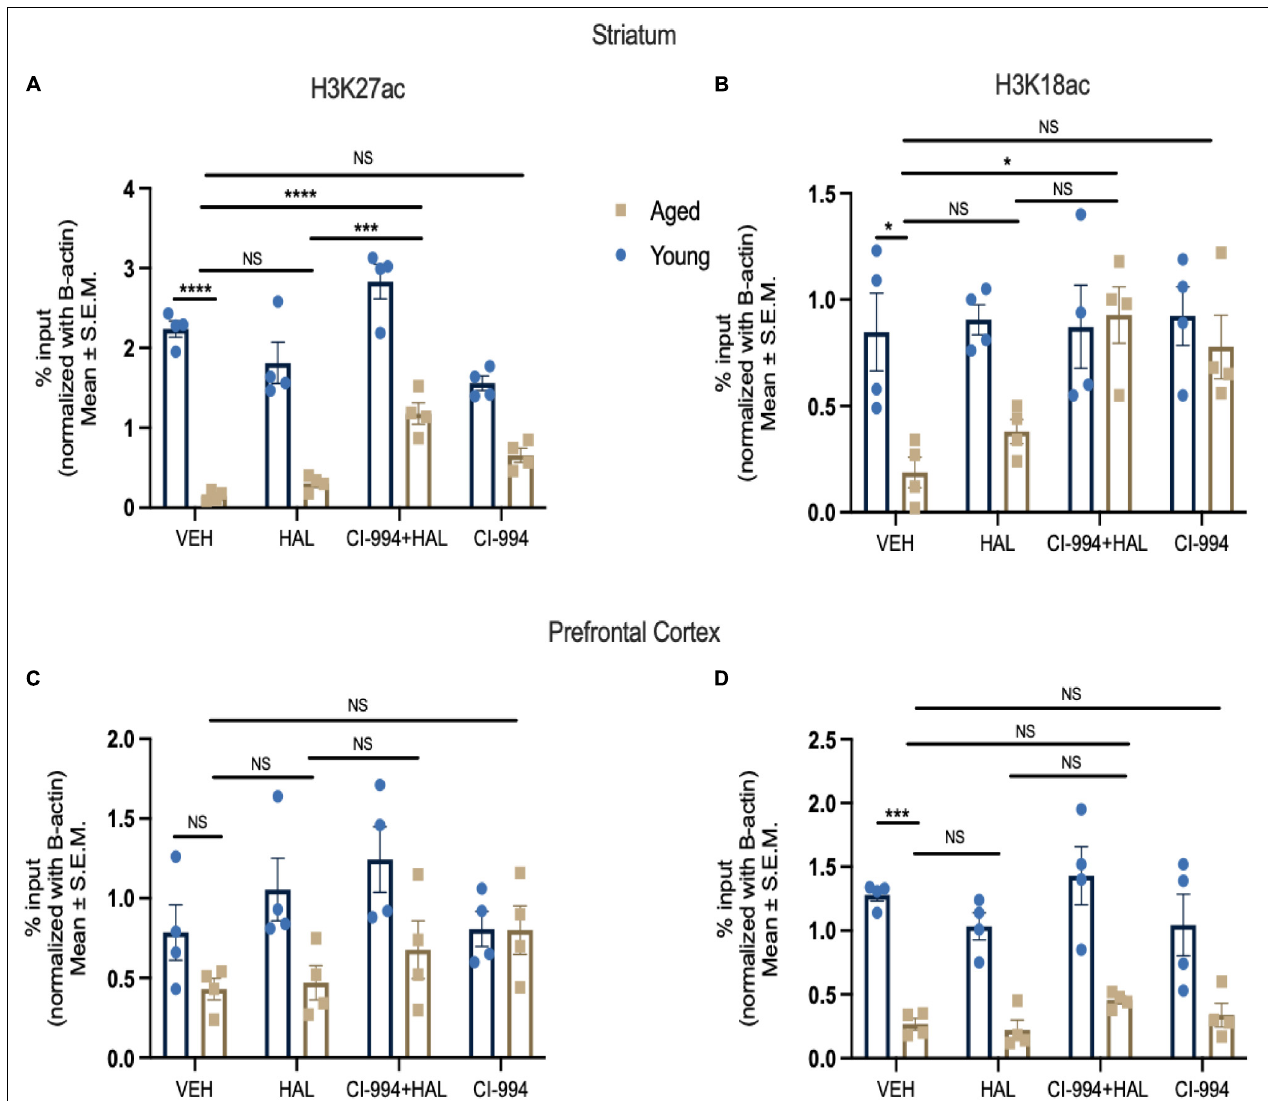
FIGURE 6 | CI-994 regulates histone acetylation at Drd2 promoter in the stratum but not prefrontal cortex. (A,B) Histone acetylation H3K27ac and H3K18ac levels at Drd2 promoter in the striatum measured as % input. (C,D) Histone acetylation H3K27ac and H3K18ac levels at Drd2 promoter in the prefrontal cortex. Aged mice showed a significant decrease of H3K27ac at the Drd2 promoter in the striatum (aged VEH vs. young VEH, p < 0.0001) and a decrease of H3K18ac at the Drd2 promoter (aged VEH vs. young VEH, p = 0.0357). HAL treatment did not change H3K27ac level at Drd2 (aged VEH vs. aged HAL, p = 0.2239) and H3K18ac (aged VEH vs. aged HAL, p = 0.9682) in aged mice. Co-treatment of CI-994 (20 mg/kg) and HAL significantly increased H3K27ac level at Drd2 (aged VEH vs. aged CI-994 + HAL, p = 0.0006; aged HAL vs. CI-994 + HAL, p = 0.00043) and H3K18ac (aged VEH vs. CI-994 + HAL, p = 0.0357) in the striatum. CI-994 20 mg/kg alone did not have a significant impact on H3K27ac (aged CI-994 + HAL 20 mg/kg vs. aged VEH, p = 0.2239), however, a trend of increased H3K18ac (aged CI-994 + HAL 20 mg/kg vs. aged VEH, p = 0.0785) levels at Drd2 in the striatum was found, but this did not reach statistical significance. In the prefrontal cortex, a significant decrease of H3K18ac but not H3K27 was found (aged VEH vs. young VEH, p < 0.0004) in the prefrontal cortex. However, there was no significant differences of H3K27ac or H3K18ac levels were found between treatment groups. Data represent mean ± SEM ( n = 4/per group). * p < 0.05, *** p < 0.001, **** p < 0.0001, NS, not